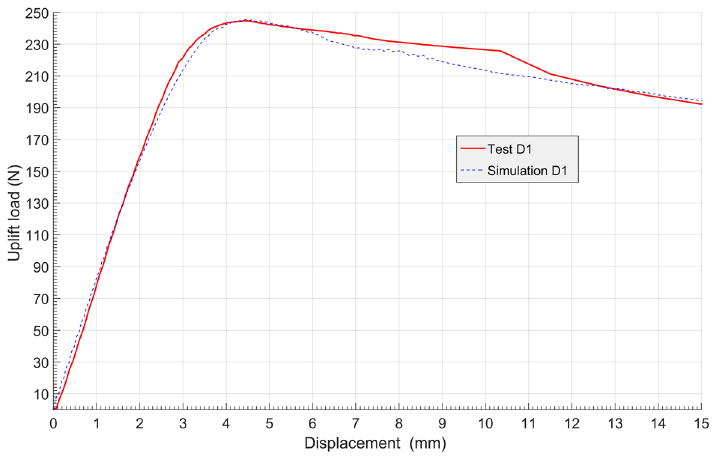
Figure 9. Comparison of D1 uplift load–displacement curves between model test and